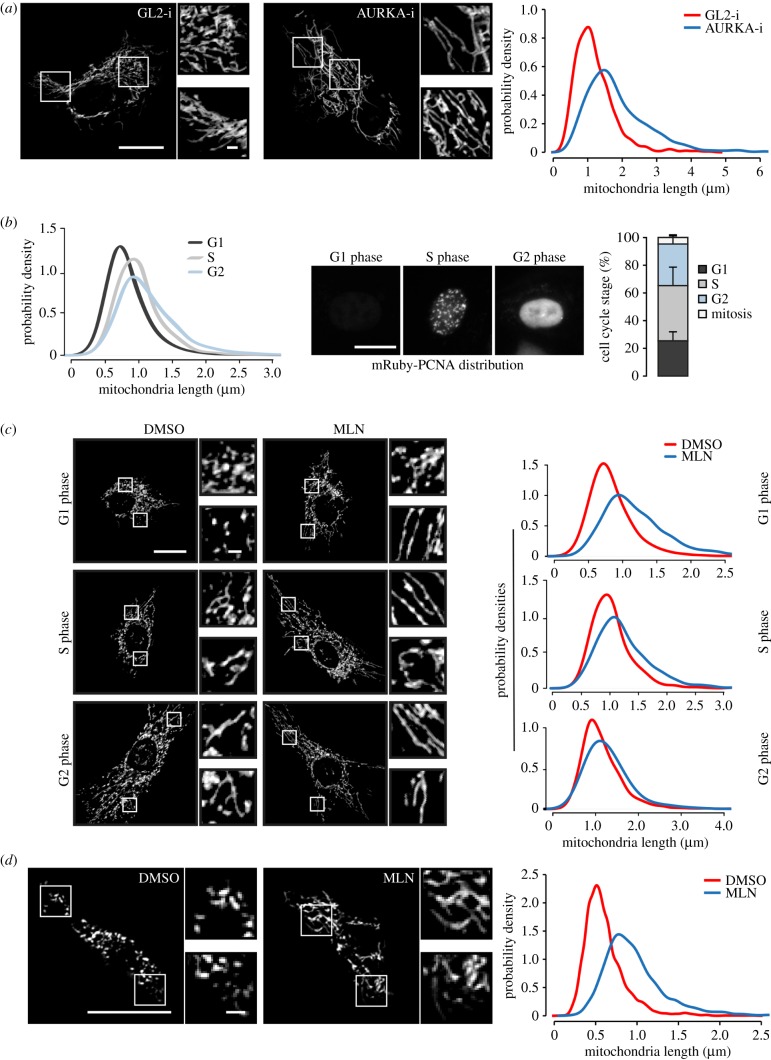
AURKA is a constitutive regulator of the mitochondrial network. (a) RPE-1 cells were treated with control (GL2-i) or AURKA siRNA (AURKA-i) for 48 h and mitochondria imaged in live cells using MitoTrackerTM. Areas of cytoplasm marked by white squares are shown enlarged twofold in panels to the side of each image. Mitochondria were analysed for tubular fragment length as described in Material and methods, with raw measurements shown as probability density plots. p < 0.001 for the maximum deviation D = 0.40 (K-S test). (b,c) RPE-1-mRuby-PCNA cells were stained with Mito-ID® green and imaged after treatment with 100 nM MLN8237 (MLN) or vehicle control (DMSO) for 3 h. (b) Tubular mitochondrial lengths are plotted as probability density curves (left-hand panel) for cells assigned to G1, S or G2 phase according to localization of mRuby-PCNA (middle panel), with cell cycle distribution summarized in the plot shown in the right-hand panel. (c) Probability density plots showing increased mitochondria length in all phases of the cell cycle after MLN treatment. G1: p < 0.001, D = 0.39; S: p < 0.001, D = 0.23; G2: p < 0.001, D = 0.13 (K-S test). (d) Drosophila D.mel-2 cells were treated with MLN for 3 h and processed as in (a). p < 0.001, D = 0.53 (K-S test). For panels (b–d): raw measurements are pooled from three statistically reproducible experimental repeats. For panels (a–d): scale bars, 10 µm in main panels, 1 µm in magnification panels.